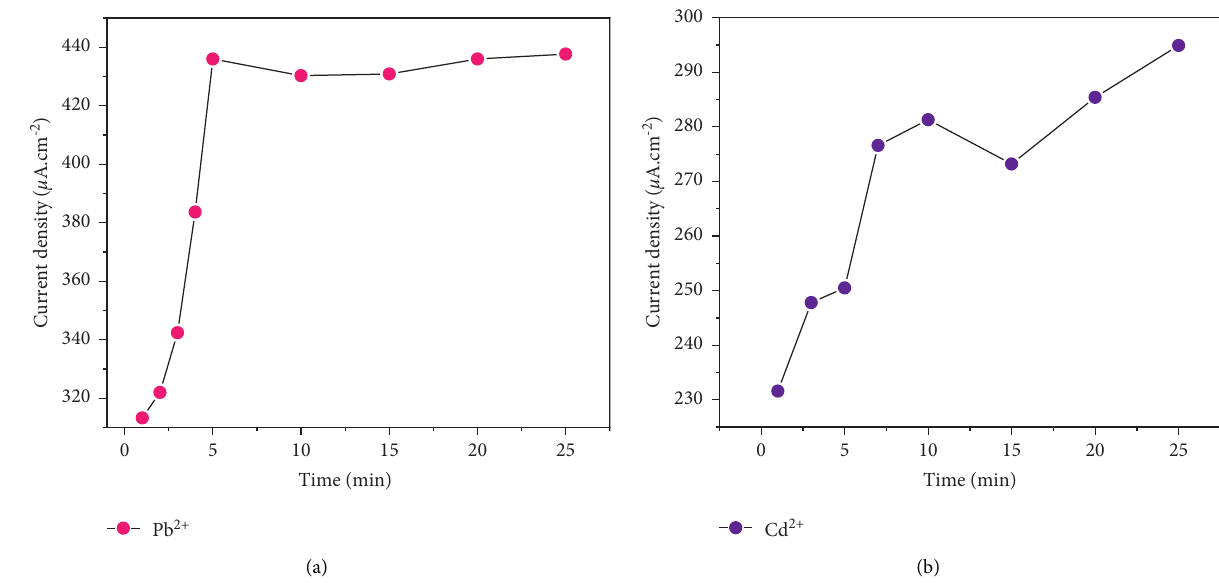
Figure 7: Effect of accumulation time by SWV (Hg/Hg